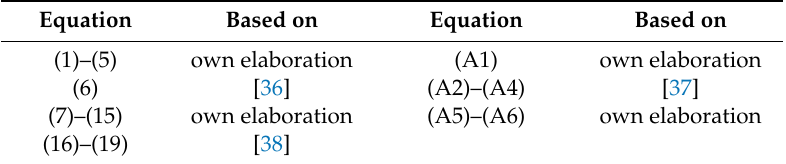
Table 1. Research method description.